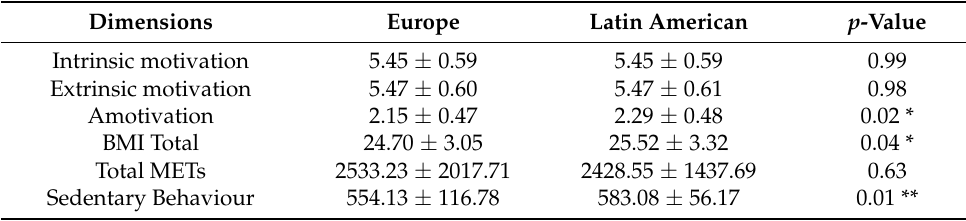
Table 4. Motivation dimensions, BMI, METs, and sedentary time by region.